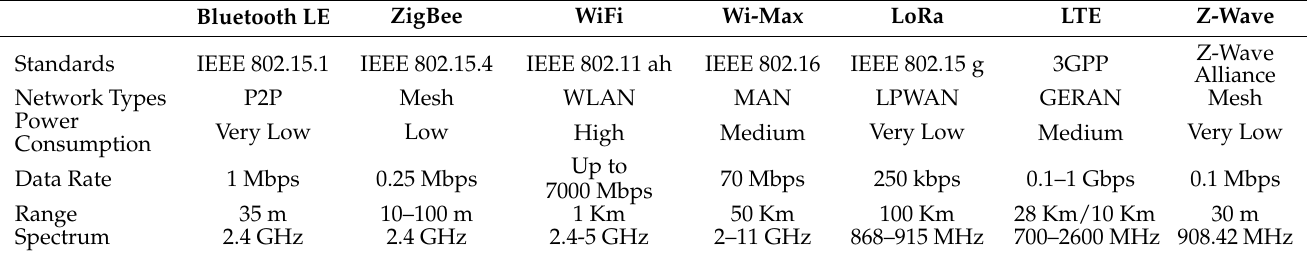
Table 1. Comparison of key wireless technology features. Adapted From: Security In Internet Of Things